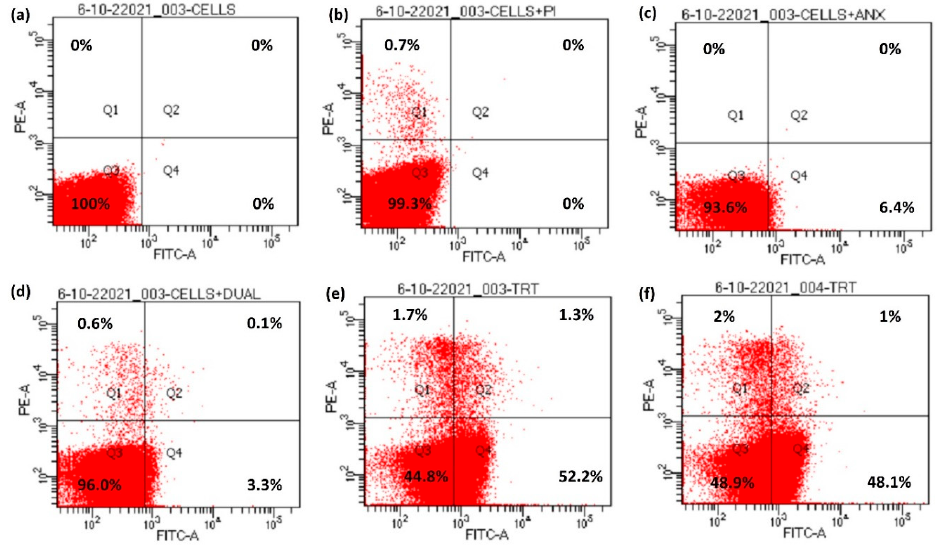
Figure 5. Externalization of phosphatidylserine in bioactive peptide-treated cells. ( a ) Unstained cells, ( b ) cells + PI, ( c ) cells + Annexin V-FITC, ( d ) cells with Annexin V-FITC + PI, ( e ) cells treated with Annexin V-FITC + PI + peptide 10d and ( f ) cells treated with Annexin V-FITC + PI + peptide 10o .